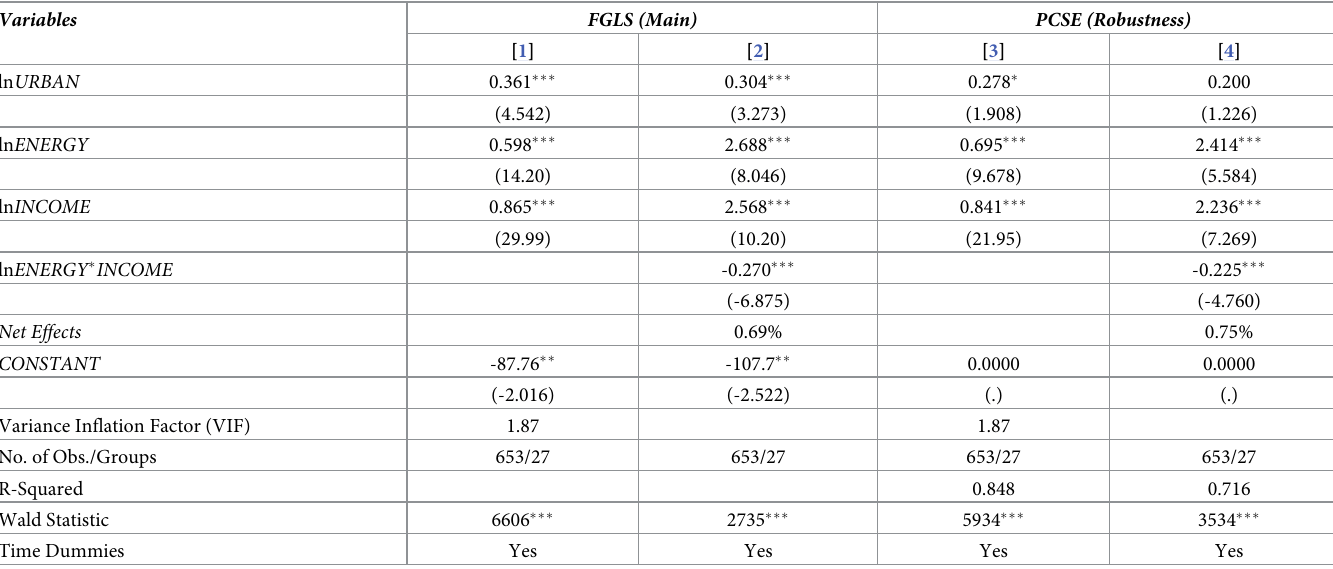
Table 2. Full sample results (Dep. Variable: